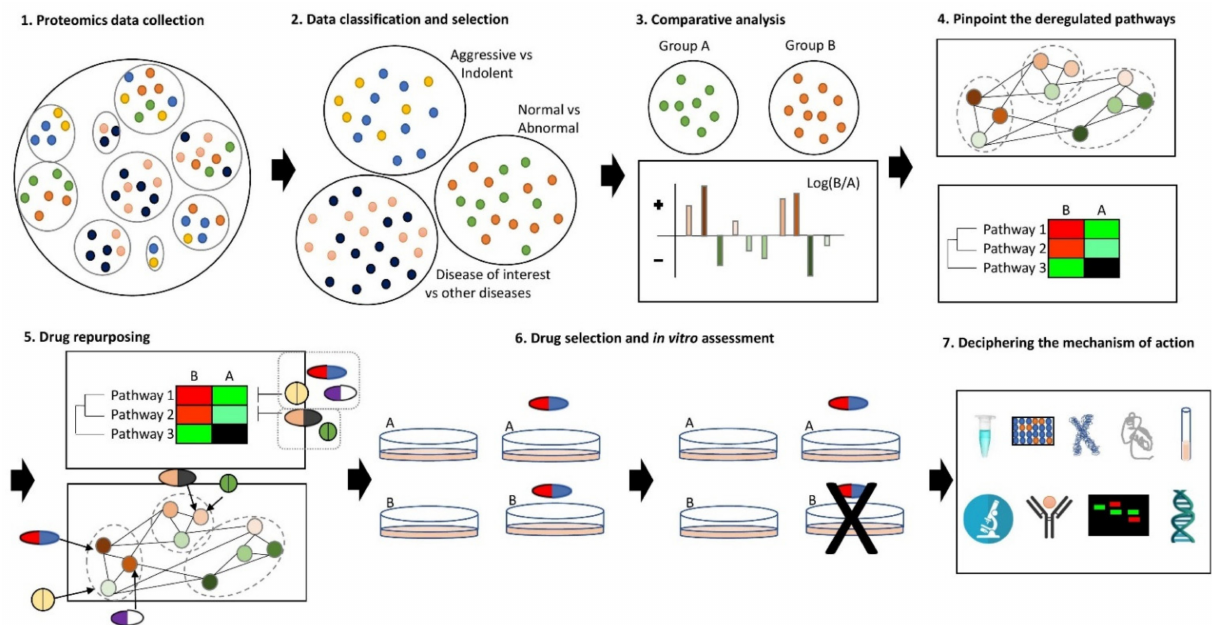
Figure 2. Drug repurposing pipeline based on proteomics data. 1 . Collection of all the available proteomics data of the disease of interest from multiple studies.